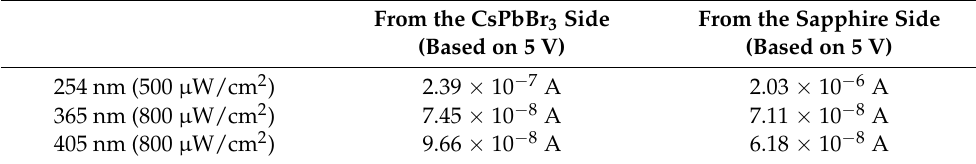
Figure 2. ( a ) Dark current of the Ga 2 O 3 PD and Ga 2 O 3 /CsPbBr 3 heterojunction PD. ( b ) Photocurrent of the Ga 2 O 3 PD and perovskite PD under a 254 nm light. Photocurrent of the Ga 2 O 3 /CsPbBr 3 heterojunction PD illuminated from the ( c ) CsPbBr 3 side and ( d ) sapphire side. ( e ) and ( f ) is the logarithmic plot of ( c ), ( d ), respectively. Table 1. The light current statistics of the Ga 2 O 3 /CsPbBr 3 heterojunction PD. From the CsPbBr 3